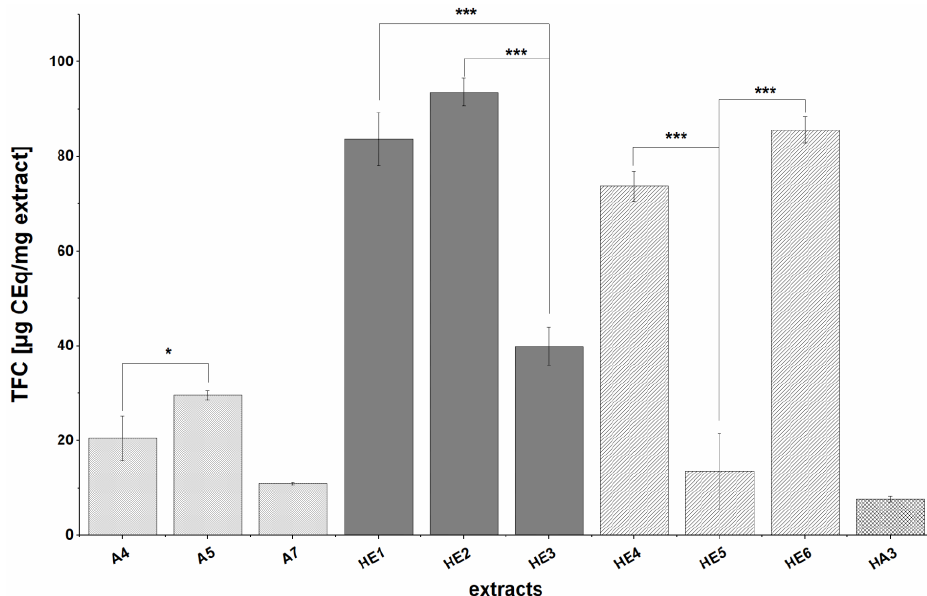
Figure 2. TFC (total flavonoid content) of extracts expressed as µg CEq/mg extract. Values are expressed as means ± SD of three to five independent experiments each performed in triplicate; significant differences within extraction groups are indicated as follows: * p < 0.05, *** p < 0.001.